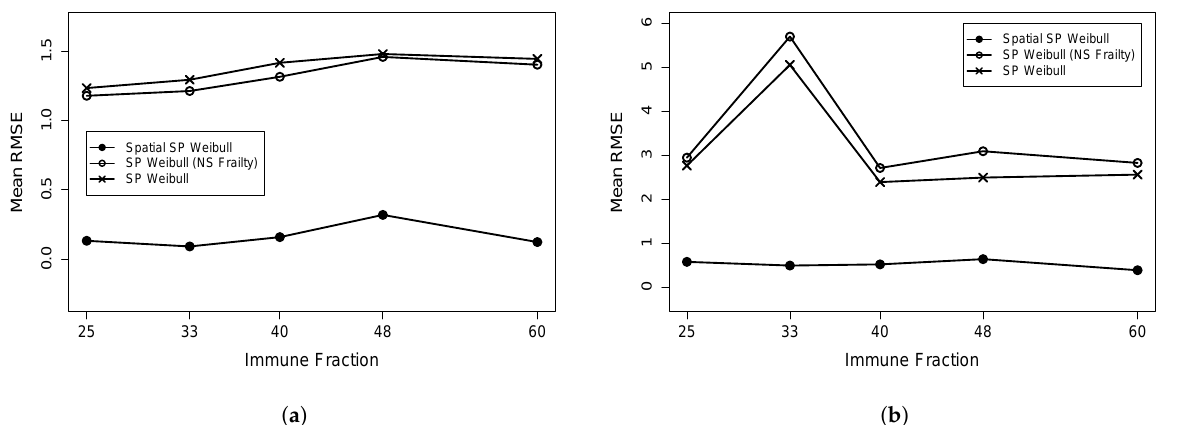
Figure 3. MC Experiment 3 mean RMSE comparison between SP Weibull, NS Frailty SP Weibull, and spatial SP Weibull models for ( a ) ˆ β coefficients and ( b ) ˆ γ coefficients with the immune fraction changing from 25% to 60% of the